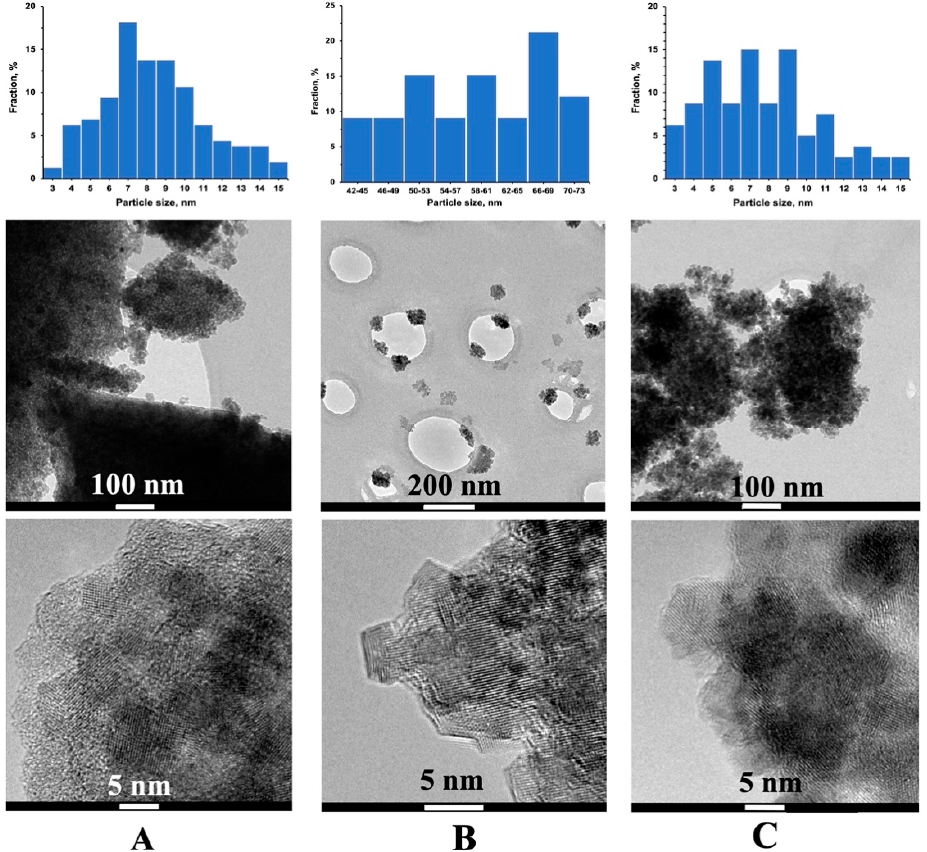
Figure 7. HR ‐ TEM (a bottom raw), TEM (a medium raw) images and histograms of the particle size distribution (a top raw) of samples produced by the EPM ( A,B ) and precipitation method ( C ) at temperatures: ( A )—450 °C (sample E2 ‐ 3); ( B )—750 °C (sample E2 ‐ 6); ( C )—450 °C (sample P ‐ 1).